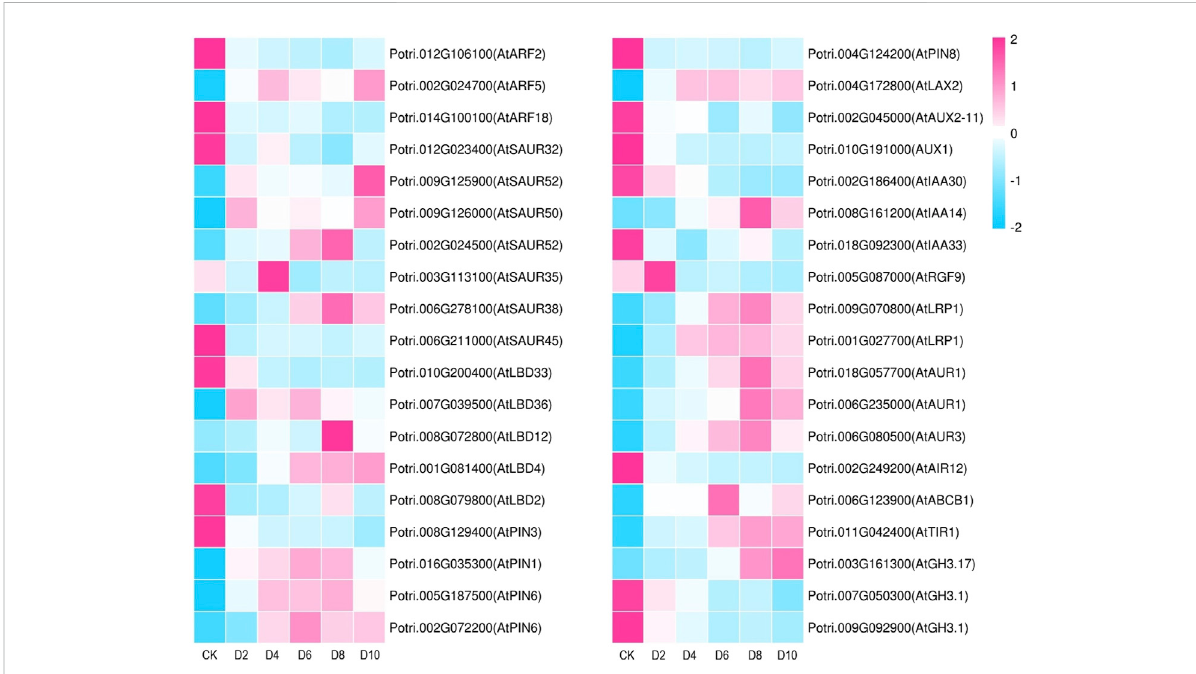
FIGURE 4 Heatmap of the expression of common DEGs related to root development and auxin signal during AR formation in poplar cuttings. D2, 4, 6, 8, 10, and CK represents 2, 4, 6, 8, 10, and 0 days of hydroponics cuttings for RNA-seq,